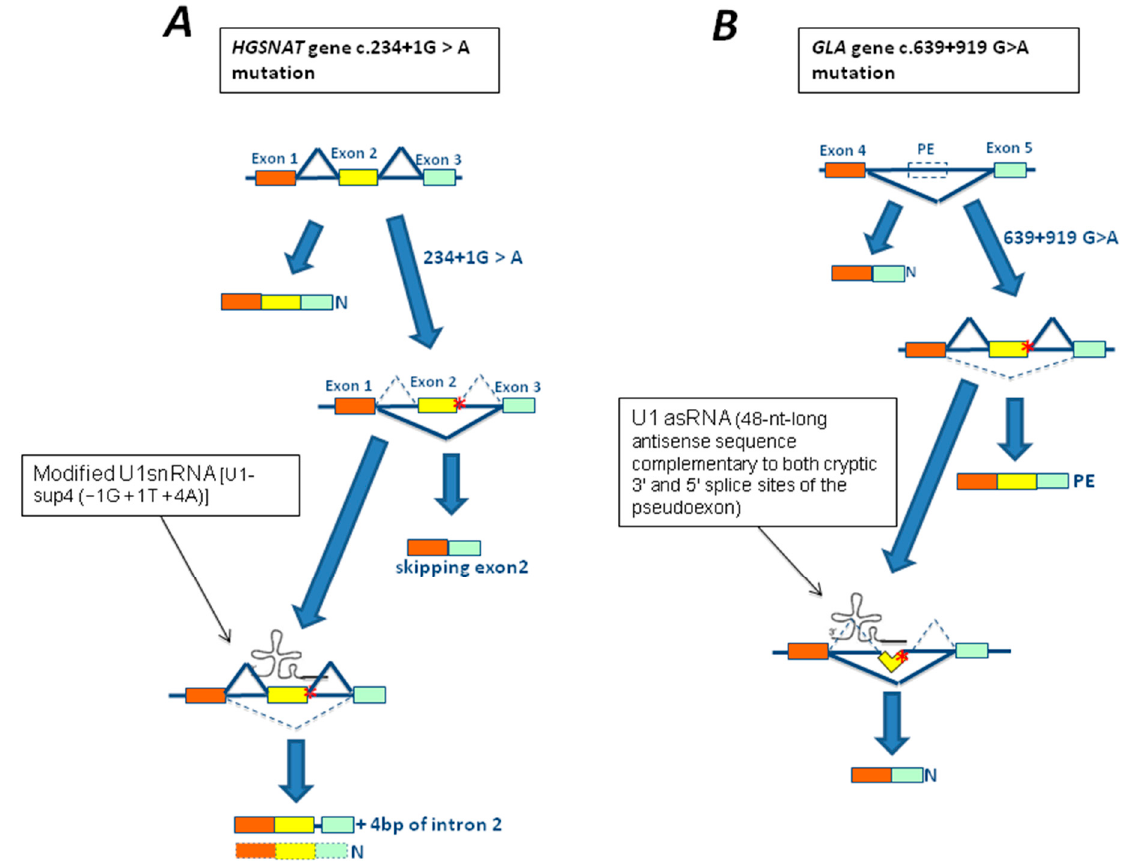
Figure 3. Rescue strategies based on modifying the U1 small nuclear RNAs (U1snRNA) architecture for mutations associated with LSDs. ( A ) Schematic representation of the 5’ portion of the heparan- α - glucosaminide N -acetyltransferase gene ( HGSNAT ), where exons are represented by colored rectangles. The c.234+1G>A mutation (red asterisk) leads to the exclusion of exon 2 from the mature mRNA. The use of a U1 fully adapted to the donor splice site of HGSNAT exon 2 [U1-sup4 ( − 1G + 1T + 4A)] resulted in a partial recovery from the splicing defect and the production of another aberrant splicing product which included the first four bp of intron 2. ( B ) Schematic representation of a portion of the α -galactosidase A gene (GLA ), where exons 4 and 5 are represented by colored rectangles while a pseudoexon is represented by an empty rectangle (PE). The c.639+919G>A mutation (red asterisk) leads to the inclusion of the pseudoexon (yellow rectangle) within the mature mRNA. The use of a chimeric U1 snRNA carrying a 48-nt-long antisense sequence complementary to both cryptic 3 ′ and 5 ′ splice sites of the pseudoexon (U1asRNA) resulted in a complete rescue of normal splicing and GLA activity. N: normal spliced mRNA.